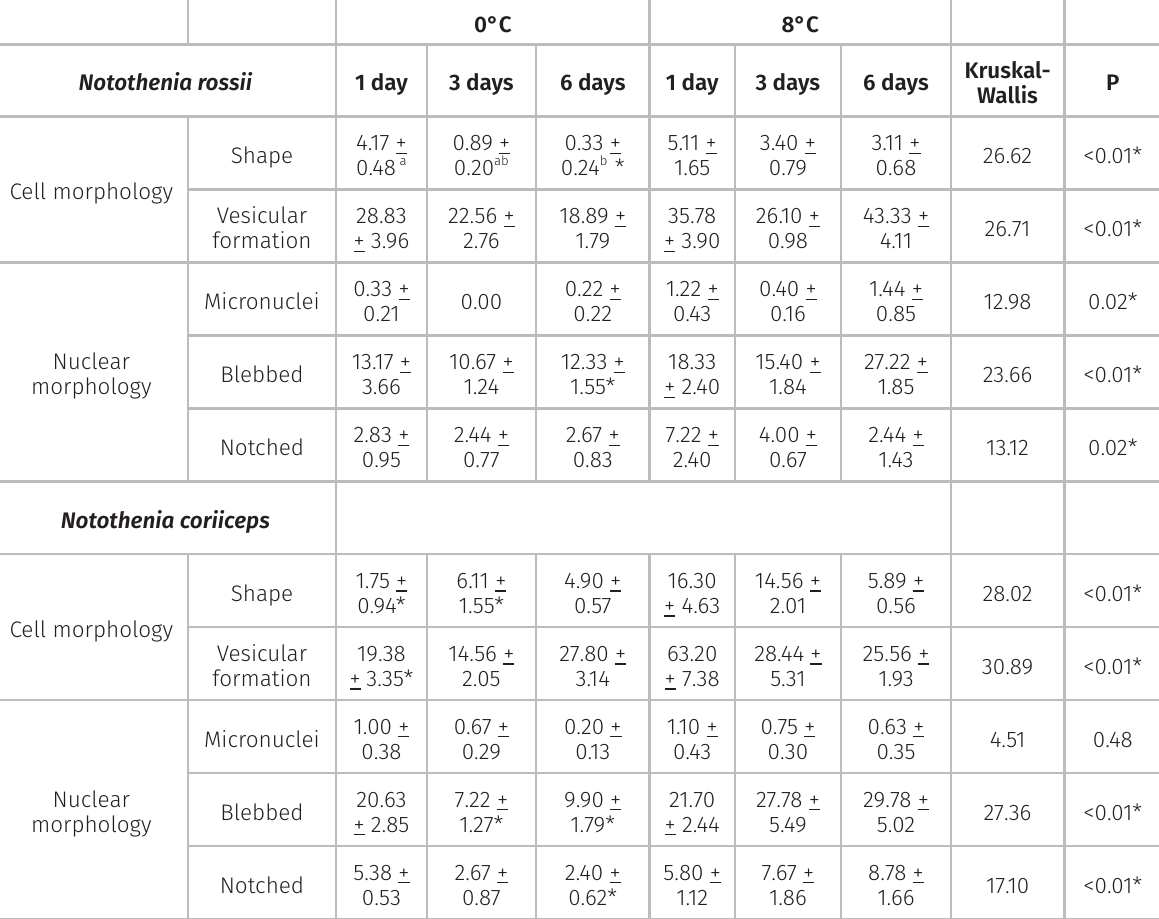
Table III. Morphological analysis in Notothenia coriiceps and N. rossii erythrocytes (Shape, vesicular formation, micronuclei, blebbed and notched: number of cells means + SE for each 1000 erythrocytes).